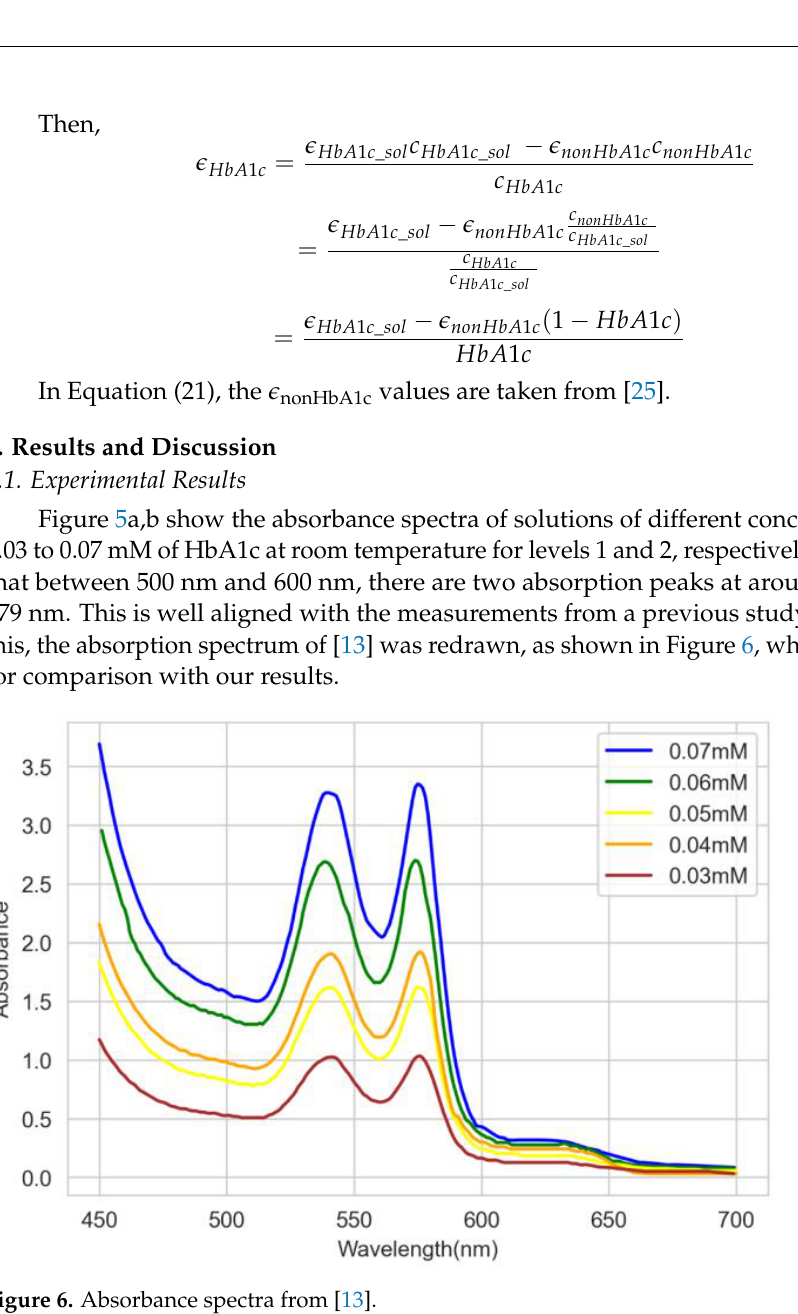
Figure 6. Absorbance spectra from [13].